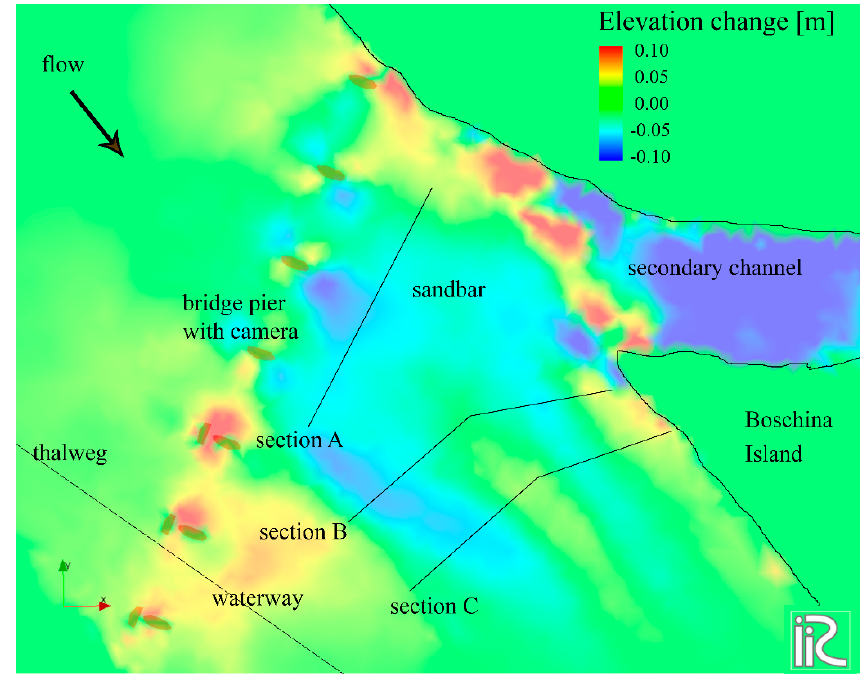
Figure 9. Simulated erosion and deposition pattern numerically modeled with iRIC.